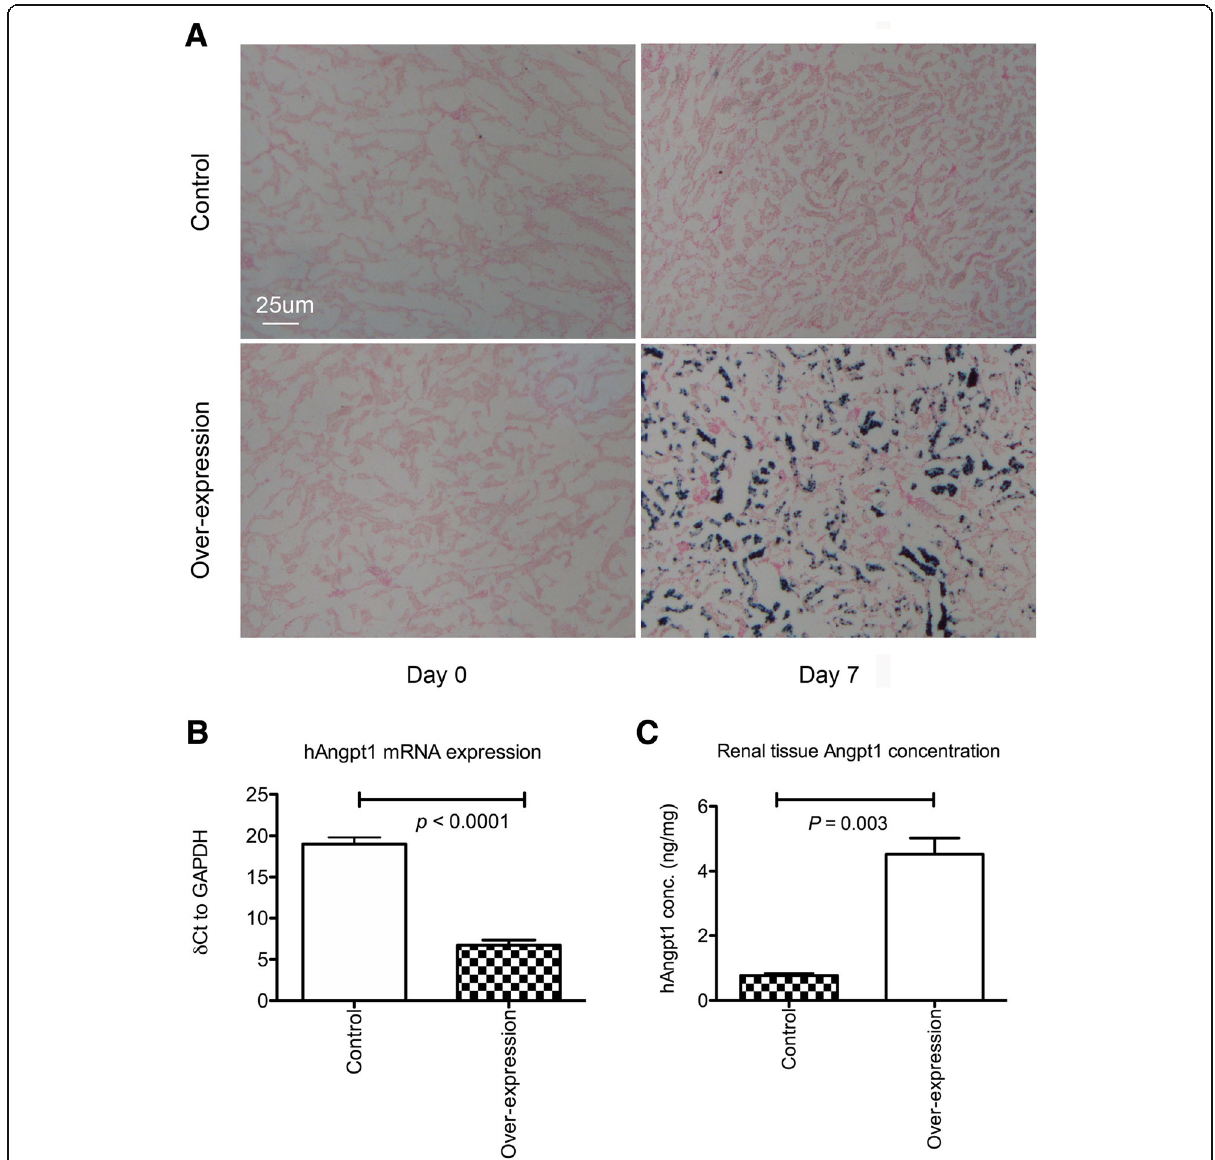
Fig. 6 a X-gal staining in the Angpt1 over-expression and control mice. Positive staining was observed in the tubular cells 7days after the initiation of supplement of doxycycline in the Angpt1 over-expression mice. The presence of positive staining indicates that the teteracycline responsive element promoter activity of Angpt1. The β -galactosidase activity in the over expression mice was activated. b Δ Ct (difference in the threshold cycle between Angpt1 and GAPDH ) of human Angpt1 mRNA by quantitative RT-PCR analysis of control and human Angpt1 over expression mice 1day after IRI. The Δ Ct in the control mice was much higher than that in the over expression mice indicating significant over-expression of human Angpt1 mRNA was observed in the over-expression mice ( N =20 per group) c Renal tissue human Angpt1 concentration in over-expression and control mice. The over- expression mice had higher renal human Angpt1 concentration than control mice ( N =8 for each